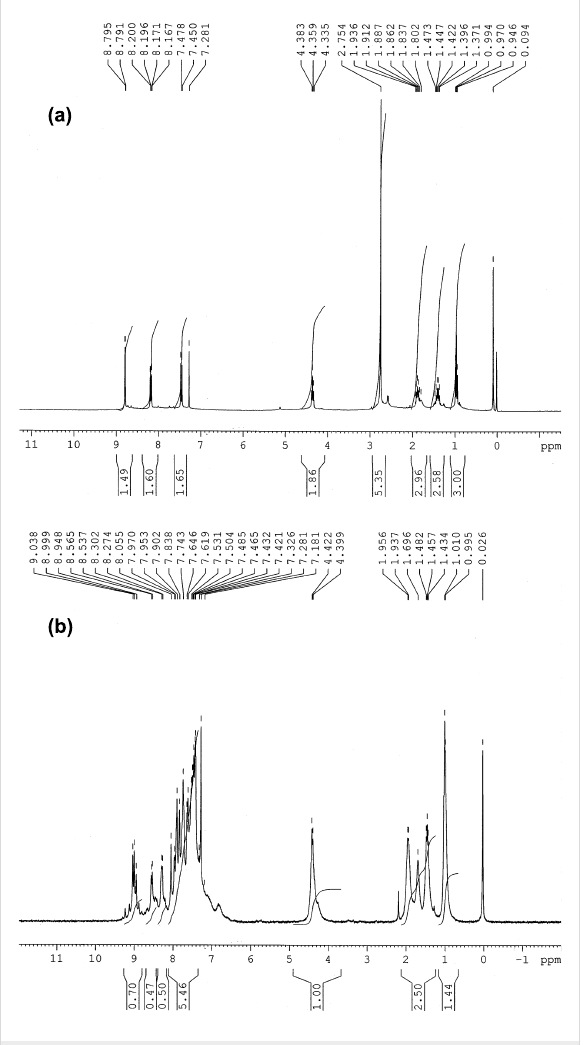
Figure 1: 1 H NMR spectra of (a) monomer 2a and (b) polymer P1a